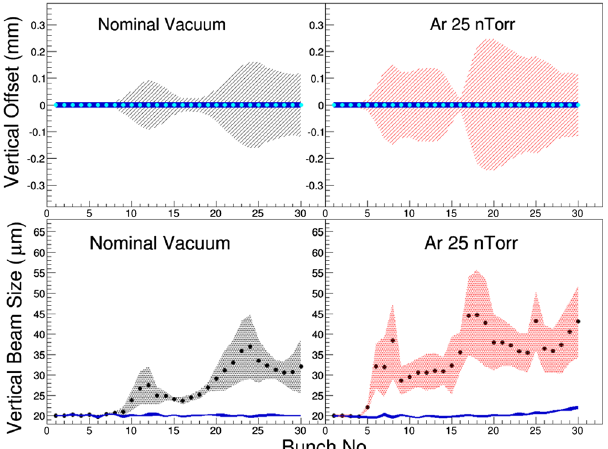
FIG. 6. Sample simulation results (14 ns spaced train with 0 . 75 mA = bunch). Vertical bunch motion (top) and size (bottom) as a function of bunch number at different pressures. (Lightly shaded ¼ RMS amplitude with vertical feedback off, filled ¼ feedback on, dots ¼ mean